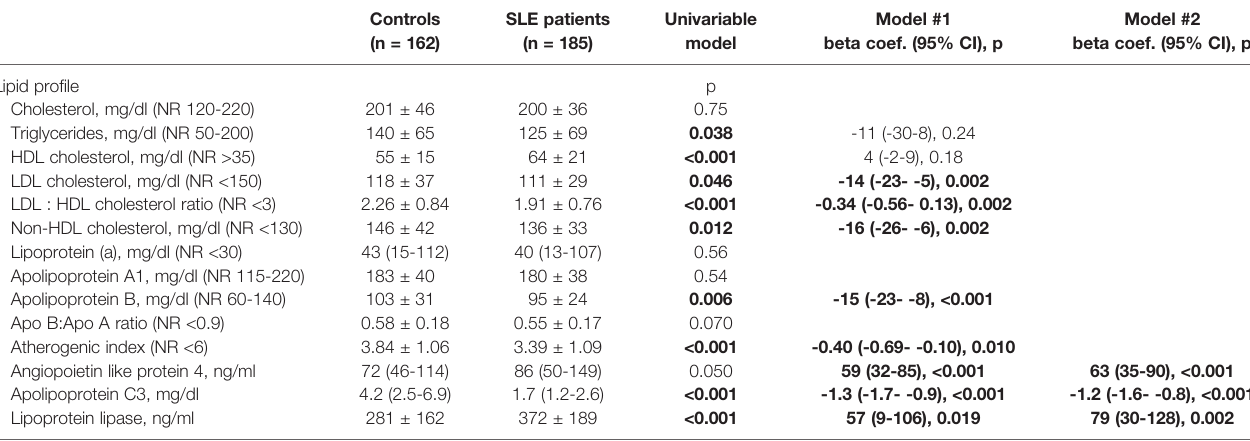
Data represent mean ± standard deviation or median (interquartile range) when data were not normally distributed. HDL, high-density lipoprotein; LDL, low-density lipoprotein; NR, Normal range. Model #1: Adjusted for body mass index, abdominal circumference, hypertension, diabetes, and aspirin intake (variables with a p value < 20 difference between patients and controls). Model #2: Adjusted for model #1 + rest of lipid molecules with a p value < 0.20 of Model 1. Because collinearity LDL cholesterol, LDL, HDL ratio, non-HDL cholesterol, apoB:apoA, and atherogenic index were excluded of the multivariable analyses in model 2. Signi fi cant values are depicted in